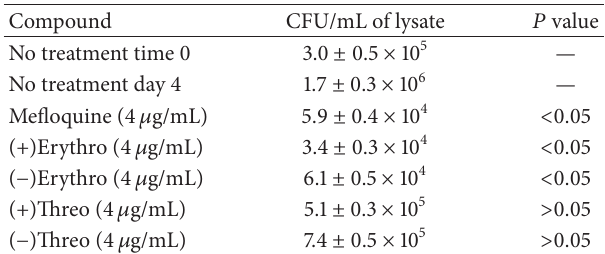
Table 4: Mefloquine and enantiomer activity against H37Rv